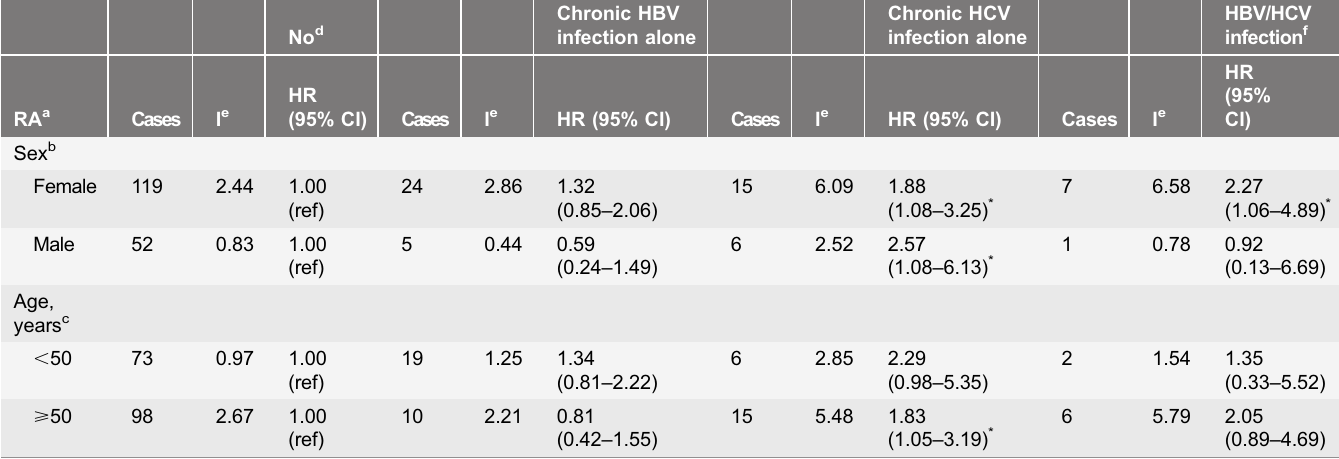
Table 3. Adjusted hazard ratios for rheumatoid arthritis (RA) associated with chronic hepatitis virus infection by sex and age. No